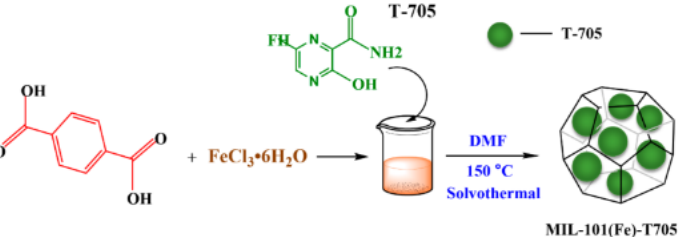
Figure 7. Scheme showing loading of favipiravir in MIL-101(Fe) during in situ synthesis. Reproduced with permission from [69] .